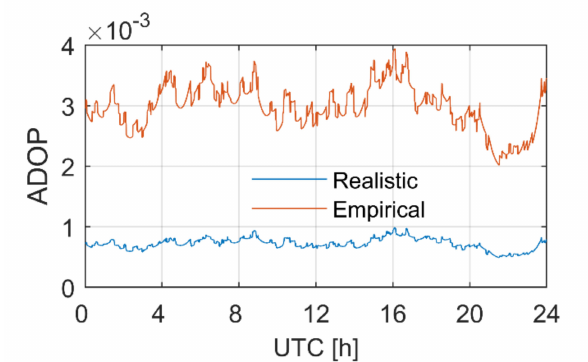
Figure 9. ADOP of GPS+BDS+Galileo dual-frequency ionosphere-fixed RTK positioning with a realistic and an empirical stochastic model. The data were collected from baseline IGG1–IGG2 on DOY 269, 2019.